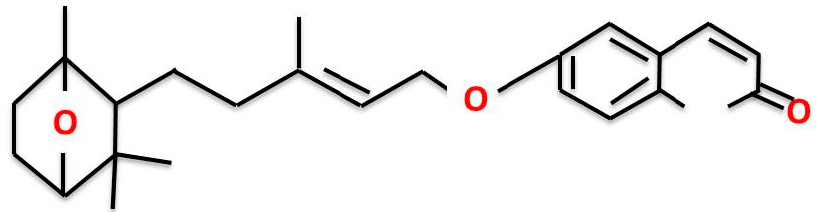
Figure 1. Structure of farnesiferol-C (Far-C).